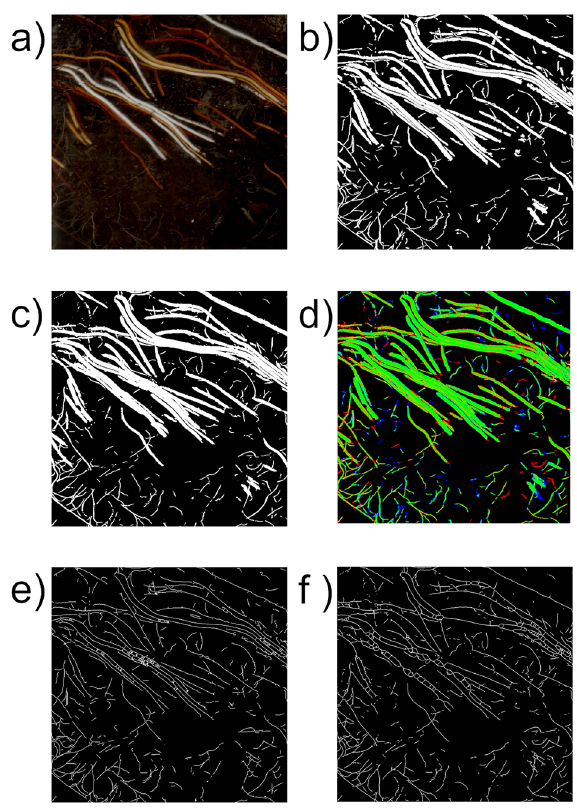
Figure 2. Example of segmentation and result of skeletonization. A 1000 by 1000 pixel input image ( a ), the manually annotated ground truth image ( b ), the RootDetector estimation image ( c ), the combined representation image (error map, d with green indicating true positives, red indicating false positive, blue indicating false negatives), the skeletonized RootDetector estimation image ( e ), and the skeletonized ground truth image ( f